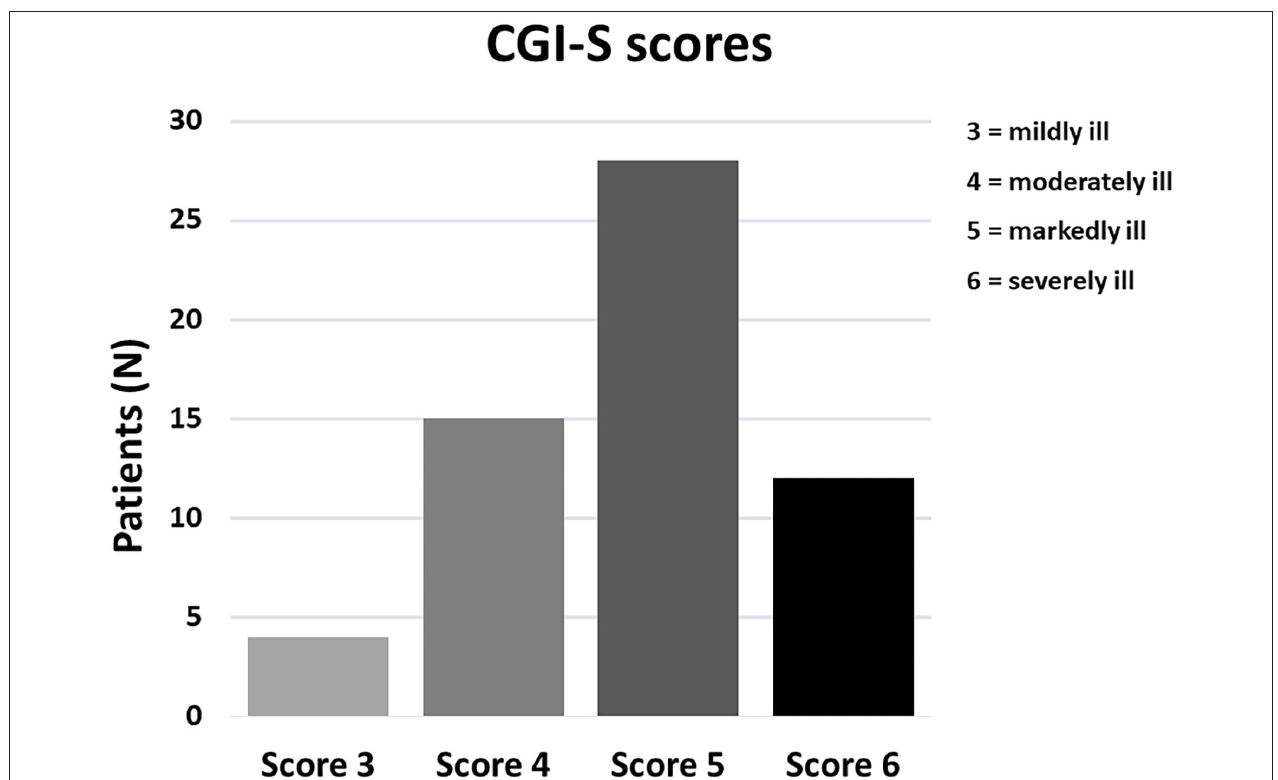
FIGURE 1 | Distribution of CGI-S severity scores in our sample of 59 patients with neurodevelopmental